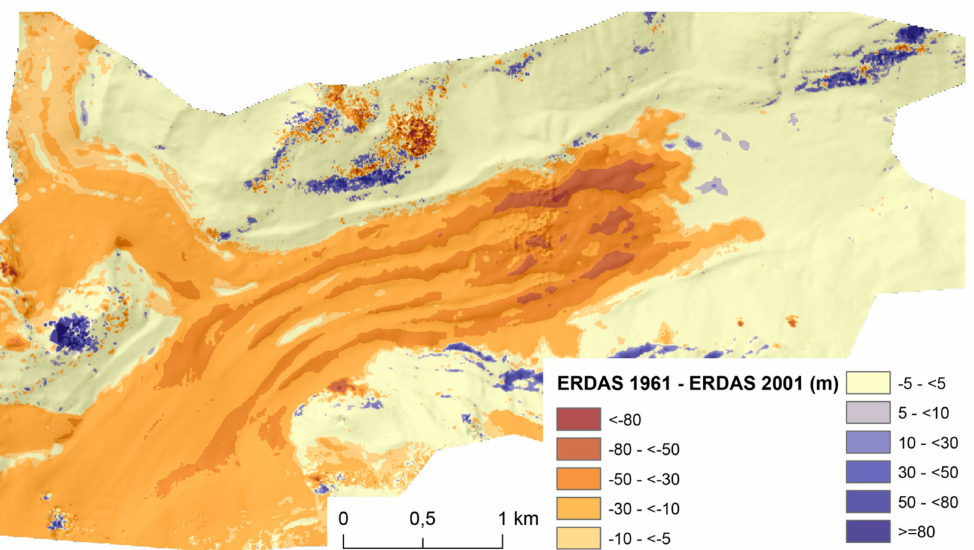
Figure 6. Example DTM difference between the ERDAS DTMs from 1961 and 2001. It shows a pattern of volume changes that is heterogeneous. The biggest changes happen in the area of ice cliffs and lakes and where debris cover is absent or sparse (compare with Figure 1).